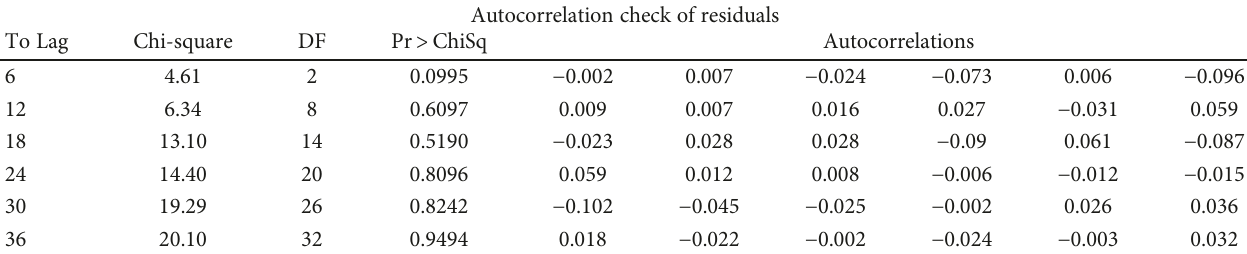
Table 2: Ljung-Box test results for ARIMA modeling of rice prices.